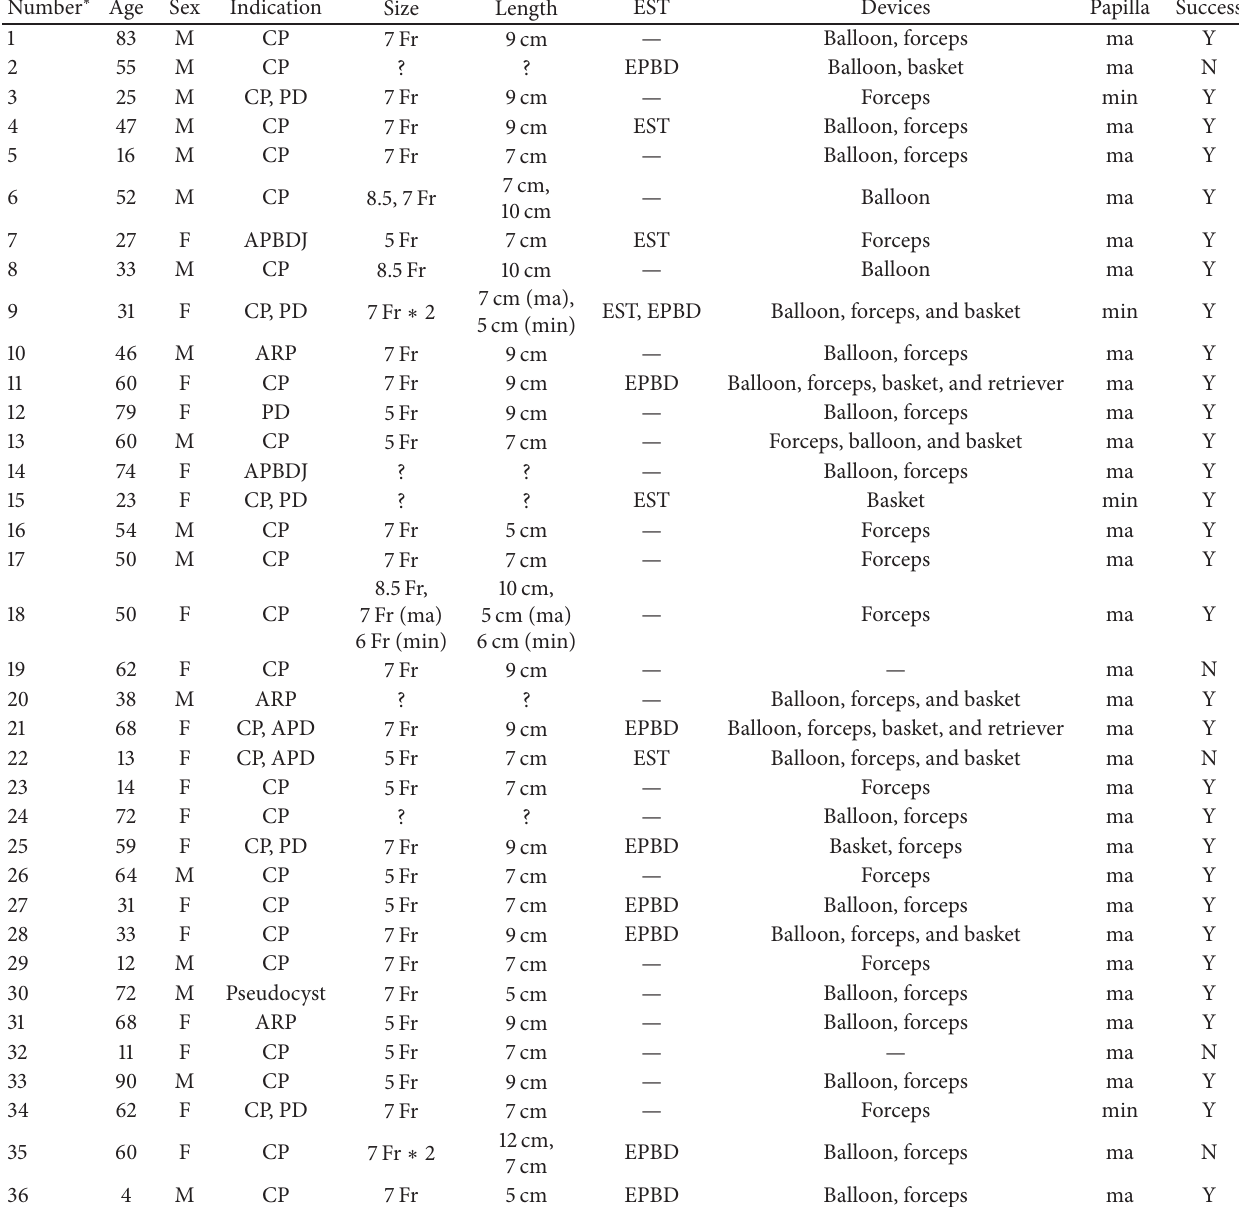
Table 1: List of the patients undergoing ERCP for migrated pancreatic stents